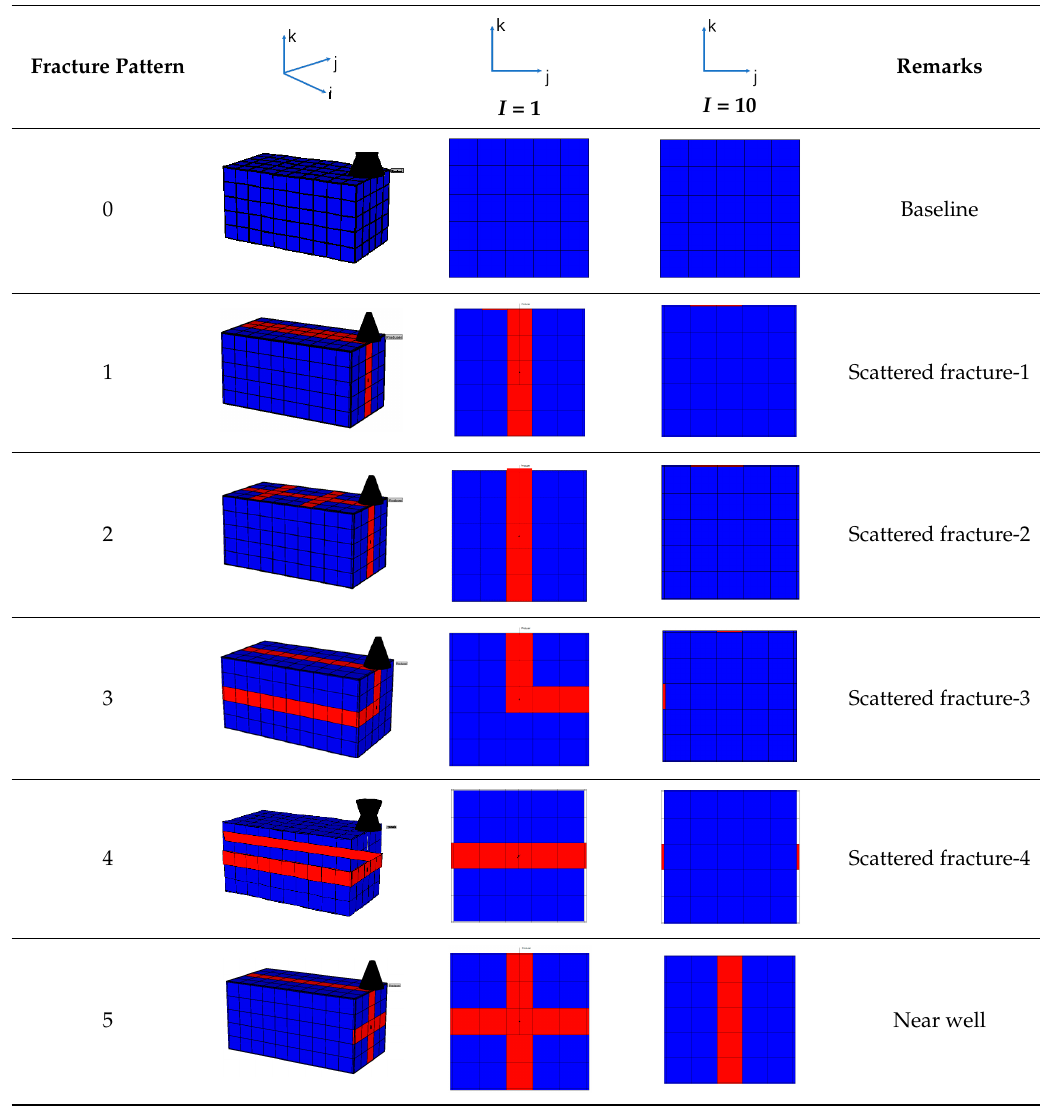
Table 5. Oil composition in the simulation model.